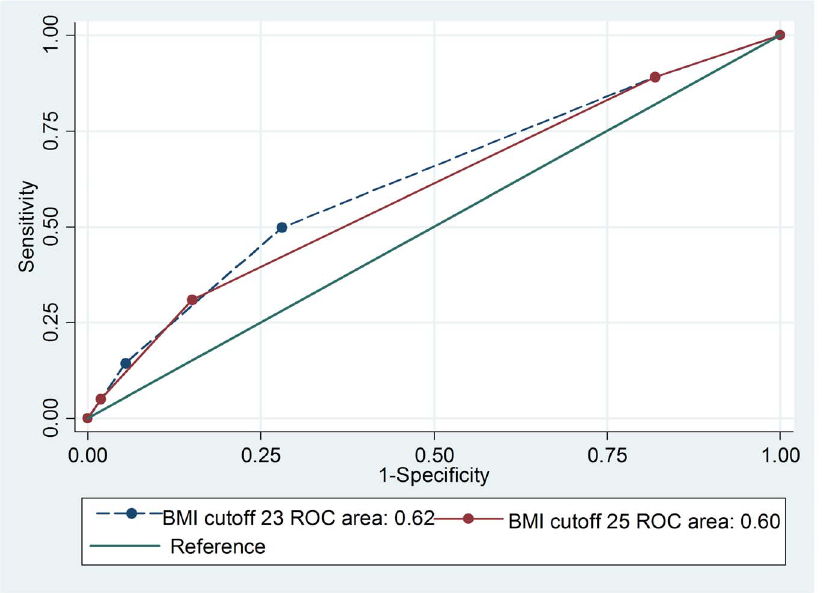
Figure 2. ROC curve comparing two BMI categories for predicting hypertension, diabetes mellitus and hypercholesterolemia in women.